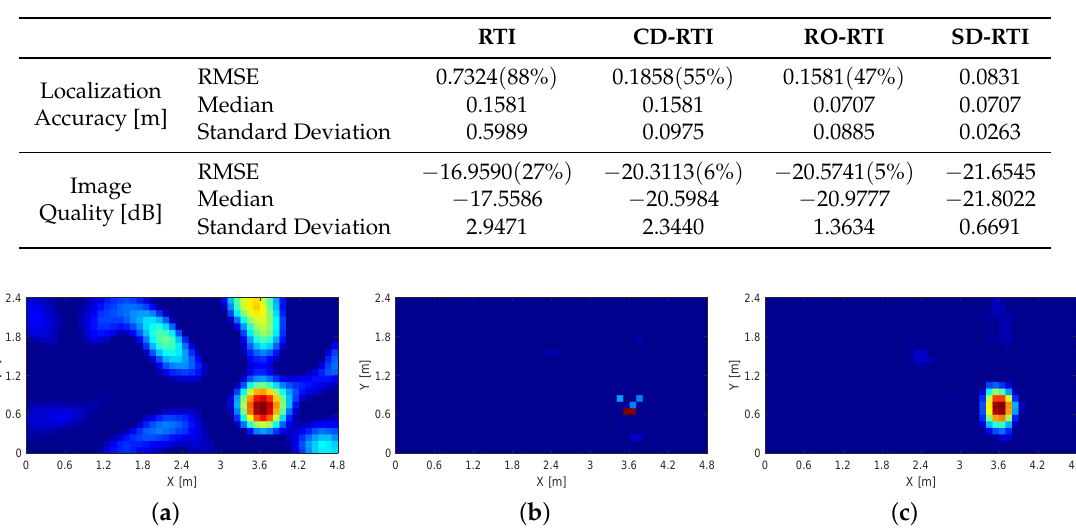
Figure 4. Localization error at individual test locations. SD-RTI achieves the best localization results. Table 1. Performance evaluation indicators of different RTI algorithms.